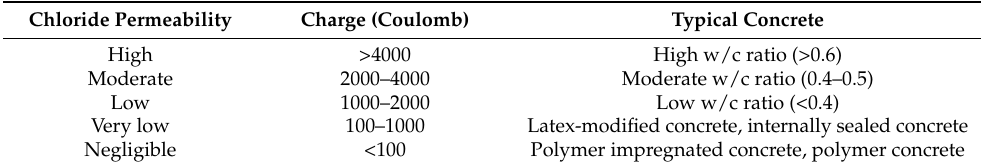
Table 5. Evaluation of chloride ion permeability